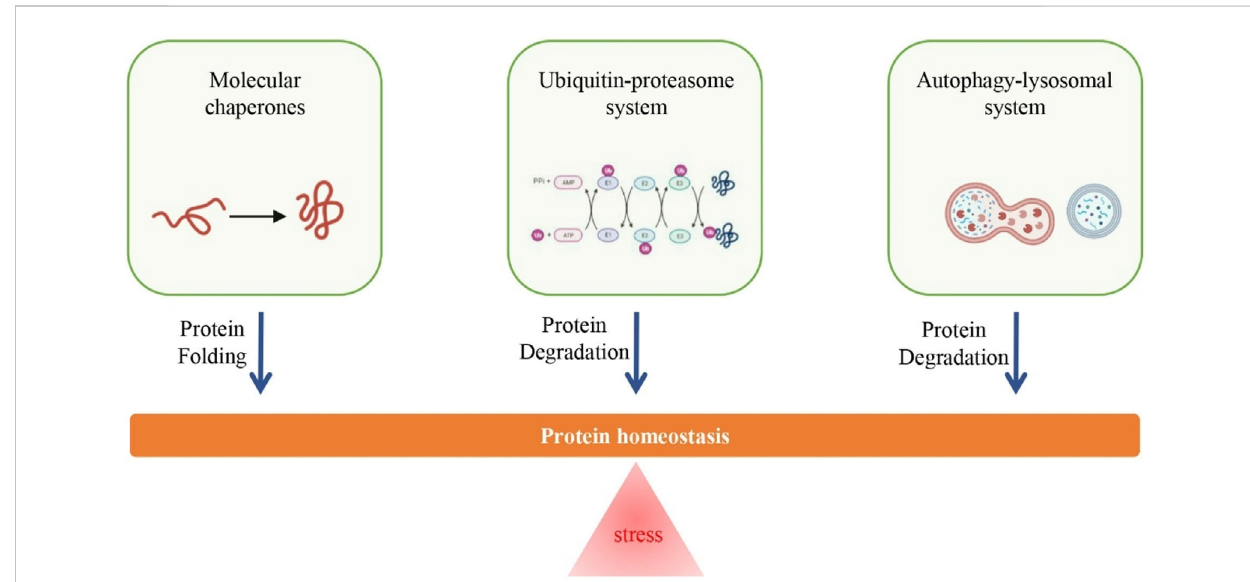
FIGURE 1 Overview of regulatory mechanisms of protein homeostasis. Long-term chronic stress (e.g., oxidative stress) is an important cause for the loss of protein homeostasis, however, the increase in the function of proteolytic system (i.e., ubiquitin-proteasome system and autophagy-lysosomal system) and repair system (i.e., molecular chaperones) can promote the maintenance of protein homeostasis.